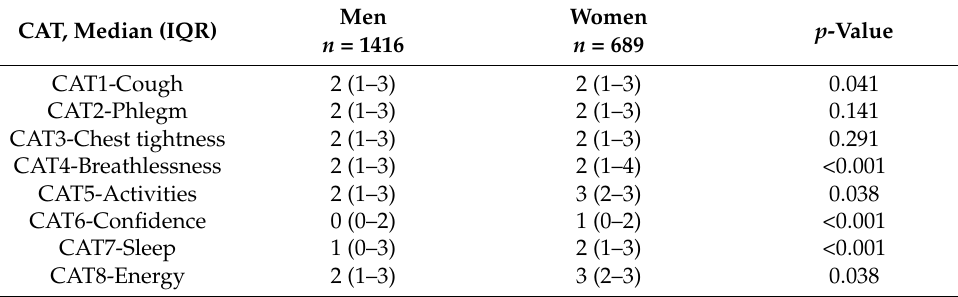
Table 2. Comparisons between men and women in